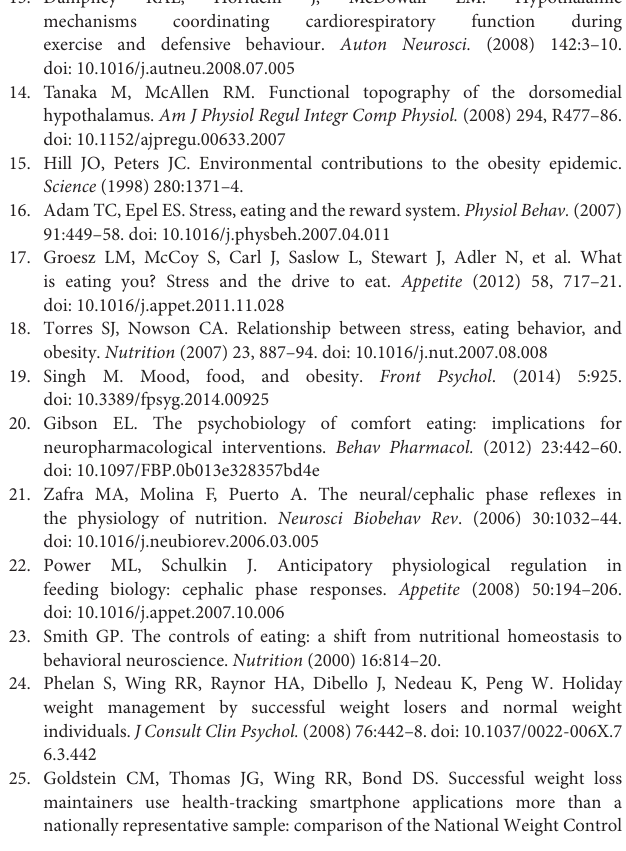
nationally representative sample: comparison of the National Weight Control